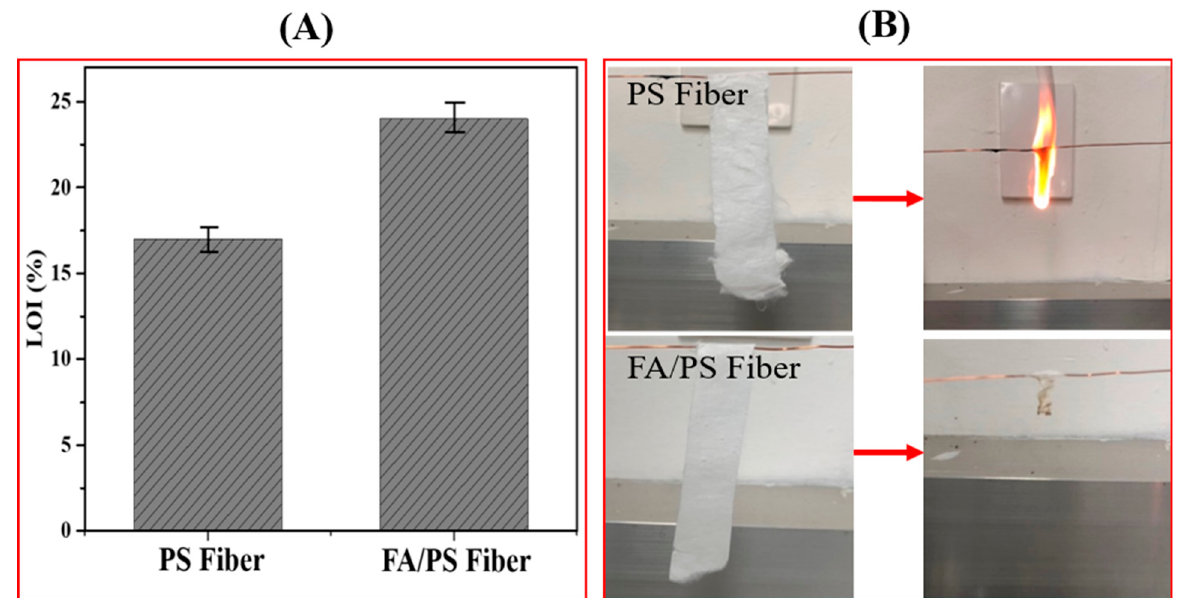
Figure 7. Comparison between the LOI values ( A ) and flame test for PS fiber and FA/PS fiber membrane ( B ).